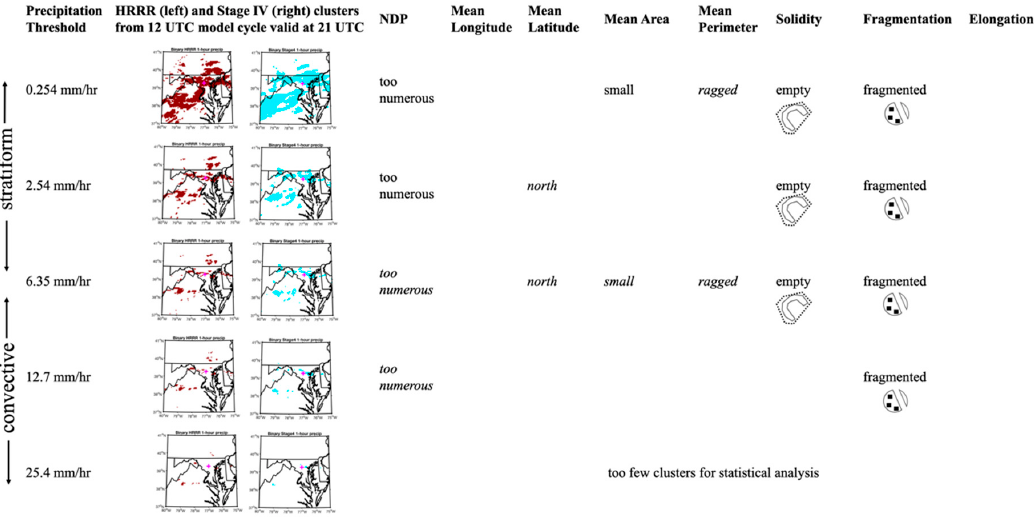
Figure 9. Summary of significant ( p < 0.1) biases in HRRR model forecast relative to Stage IV observations for the 27 May 2018 case study. To illustrate the biases, the 12 UTC model forecast and observations valid at 21 UTC are provided for each precipitation threshold. Consistent biases (identified over multiple model cycles) are in normal font and more intermittent biases (identified in one or two model cycles) are in italicized font. Table 6. Mann–Whitney U p -values for 0.254 mm h − 1 (0.01 in h − 1 ) threshold for 27 May 2018 case. Bold font face indicates significance at 90% confidence threshold. HRRR